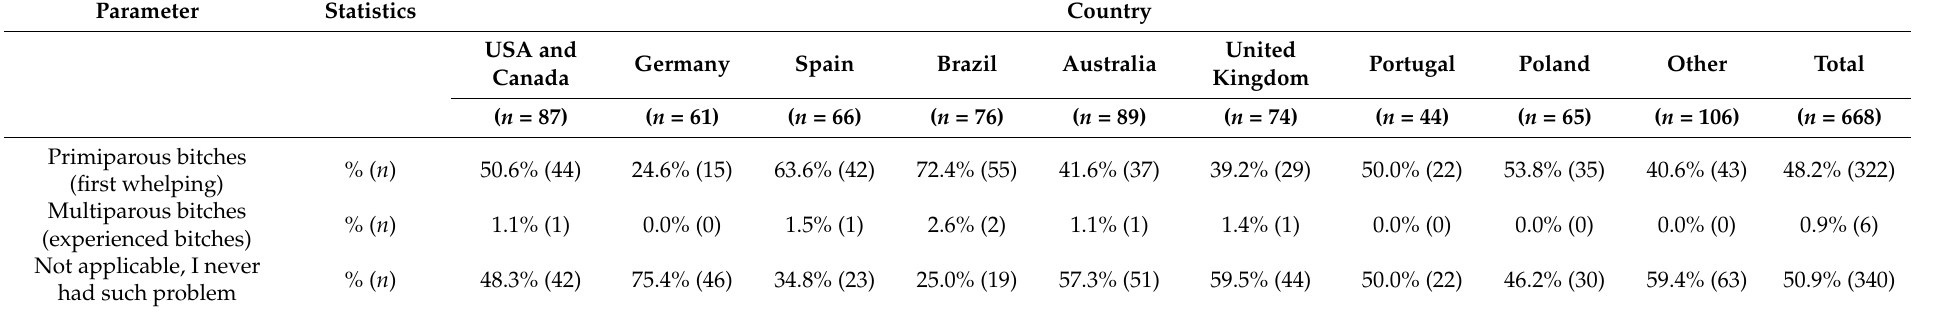
Table 2. Inappropriate maternal behaviour according to parity based on different countries ( n = 668).